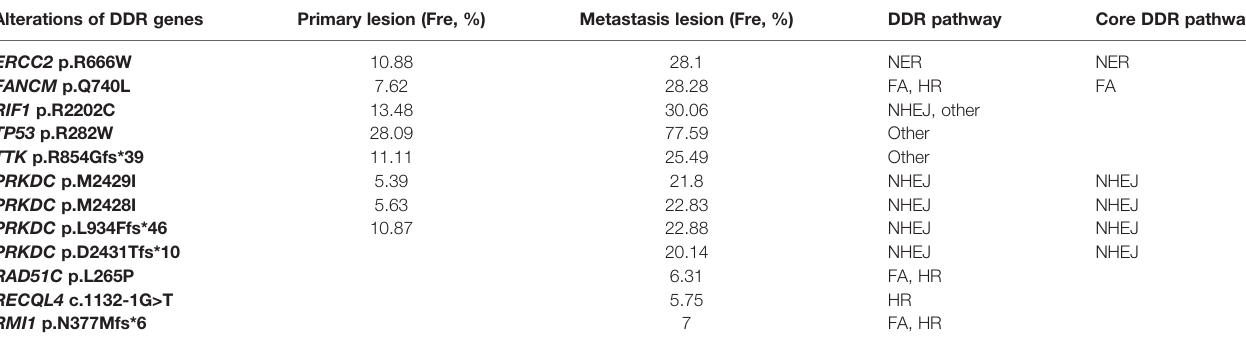
TABLE 1 | Alterations of DDR (DNA damage repair) genes in primary and metastatic lesions. Alterations of DDR genes Primary lesion (Fre,